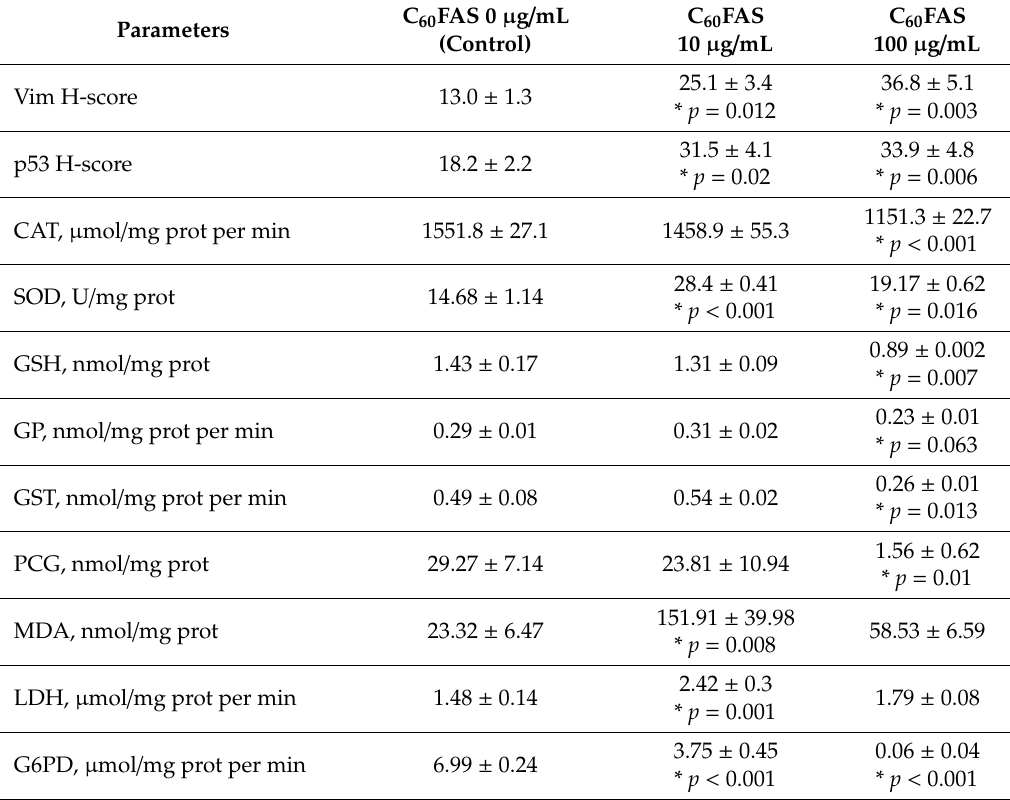
Table 1. H-score, redox and energy state markers of HepG2 cells after 48 h cultivation in medium contained C 60 FAS (M ±